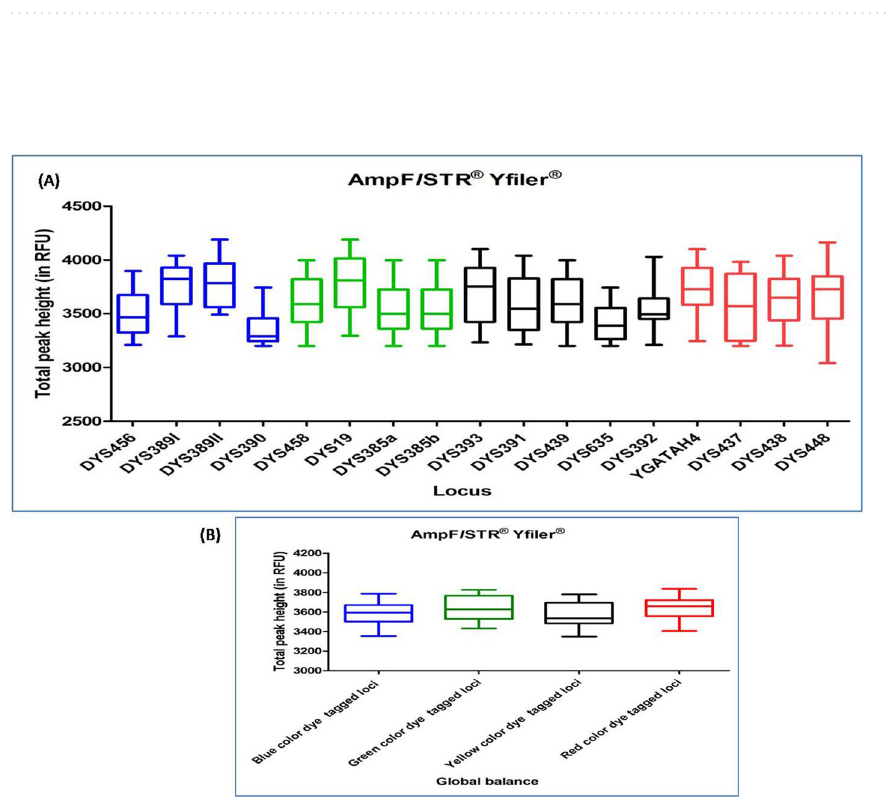
Figure 12. Quality assessment of DNA profile by Dunn’s multiple comparison test for the AMPFLSTR YFILER PCR AMPLIFICATION KIT ( A ) Total peak height ( B ) Global